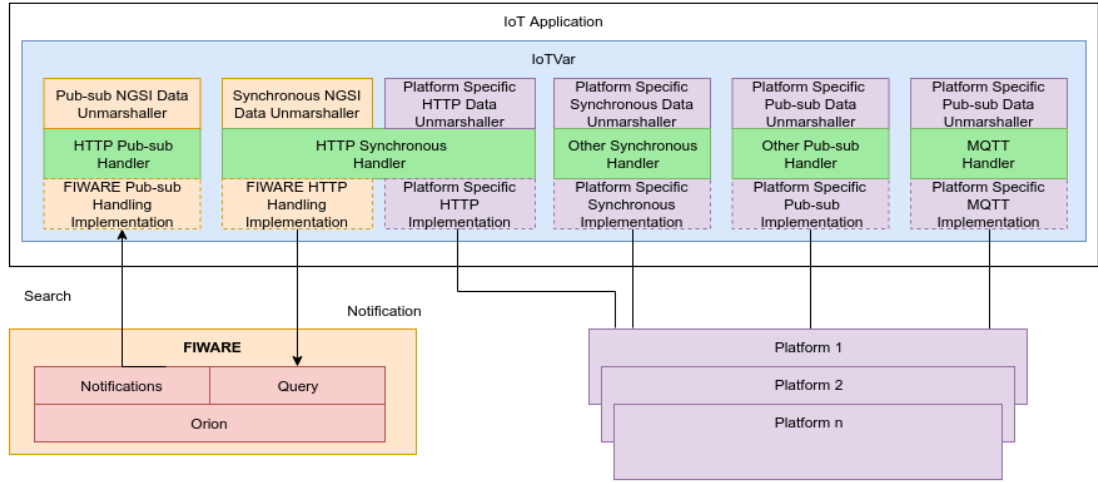
Figure 3. Integration architecture of IoTVar with the FIWARE